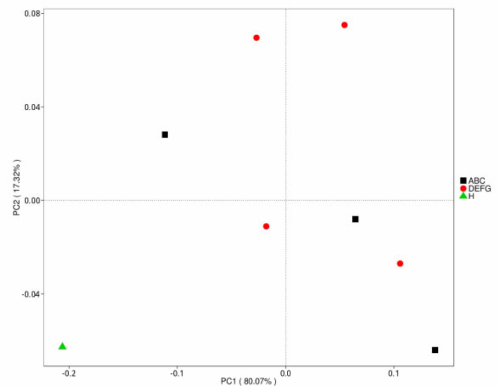
Figure 10. Species PCoA results based on the phylum level. Note: the abscissa represents one principal component, the ordinate represents another principal component, and the percentage represents the contribution value of the principal component to the sample difference. Each point in the figure represents a sample, and the samples in the same group are represented by the same colour.